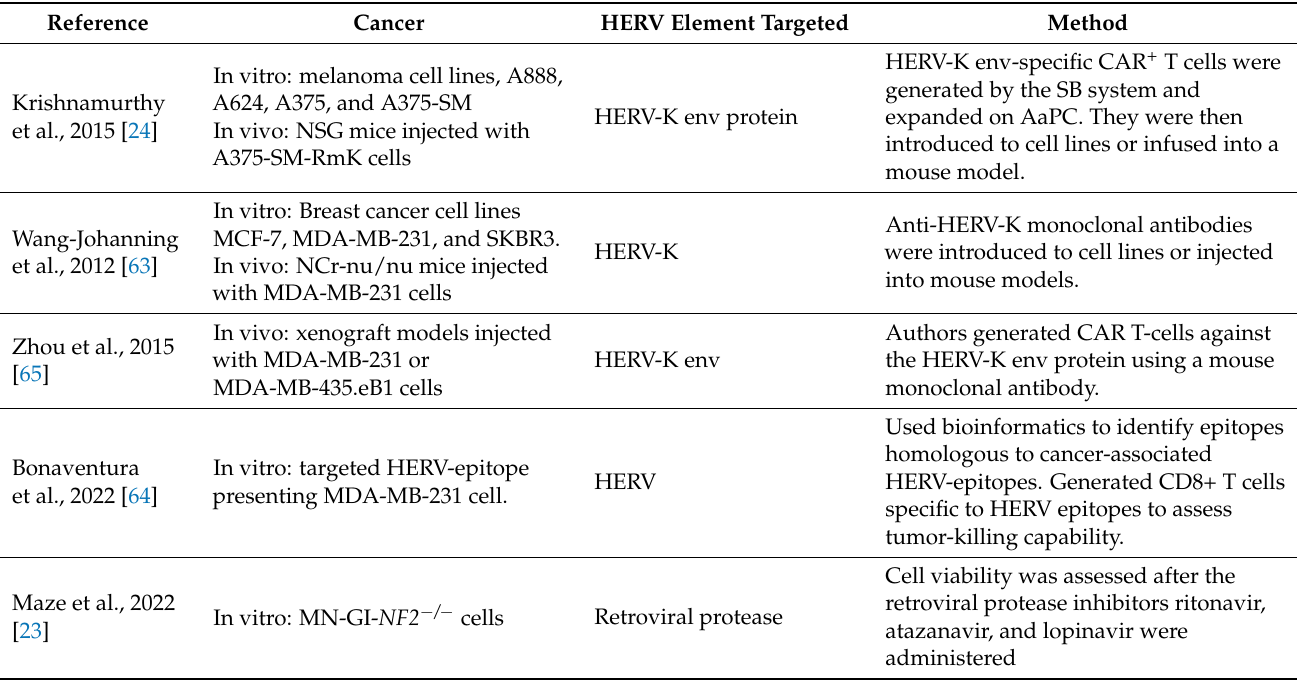
Table 2. Therapeutic approaches for targeting HERV-K in